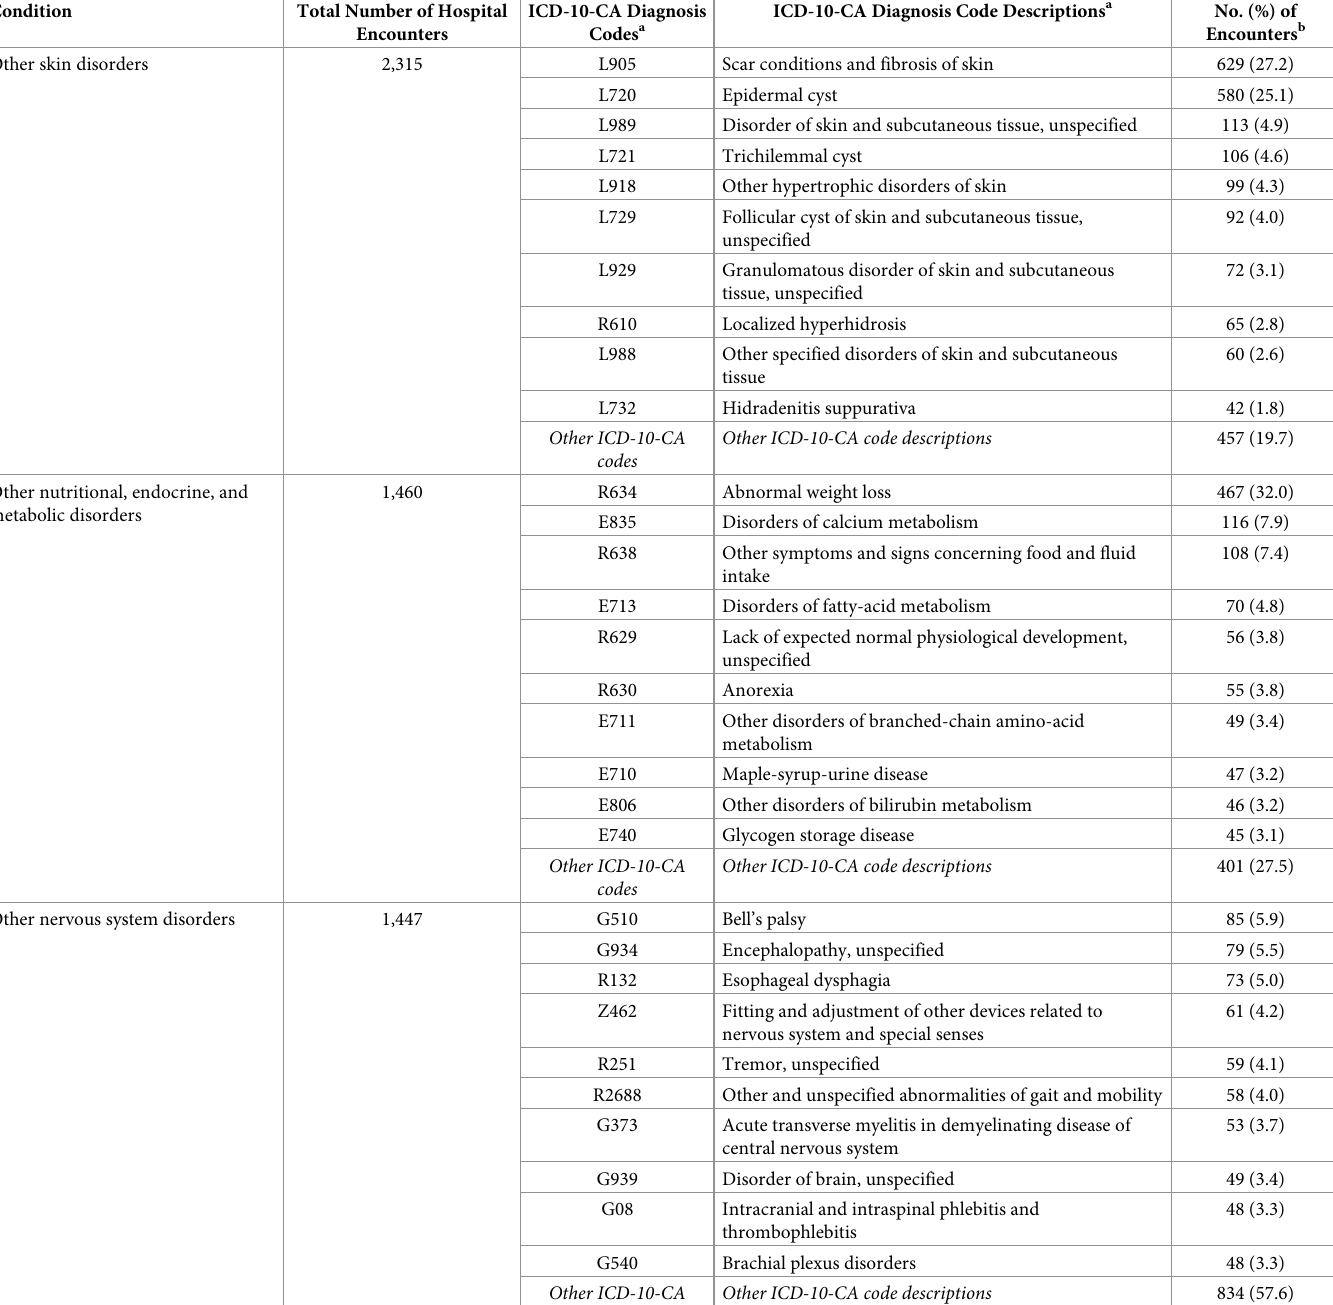
Table 2. Examples of non-specific pediatric conditions in PECCS-CA and the 10 most responsible ICD-10-CA diagnosis codes that led to hospital encounters for the conditions in children in Ontario,